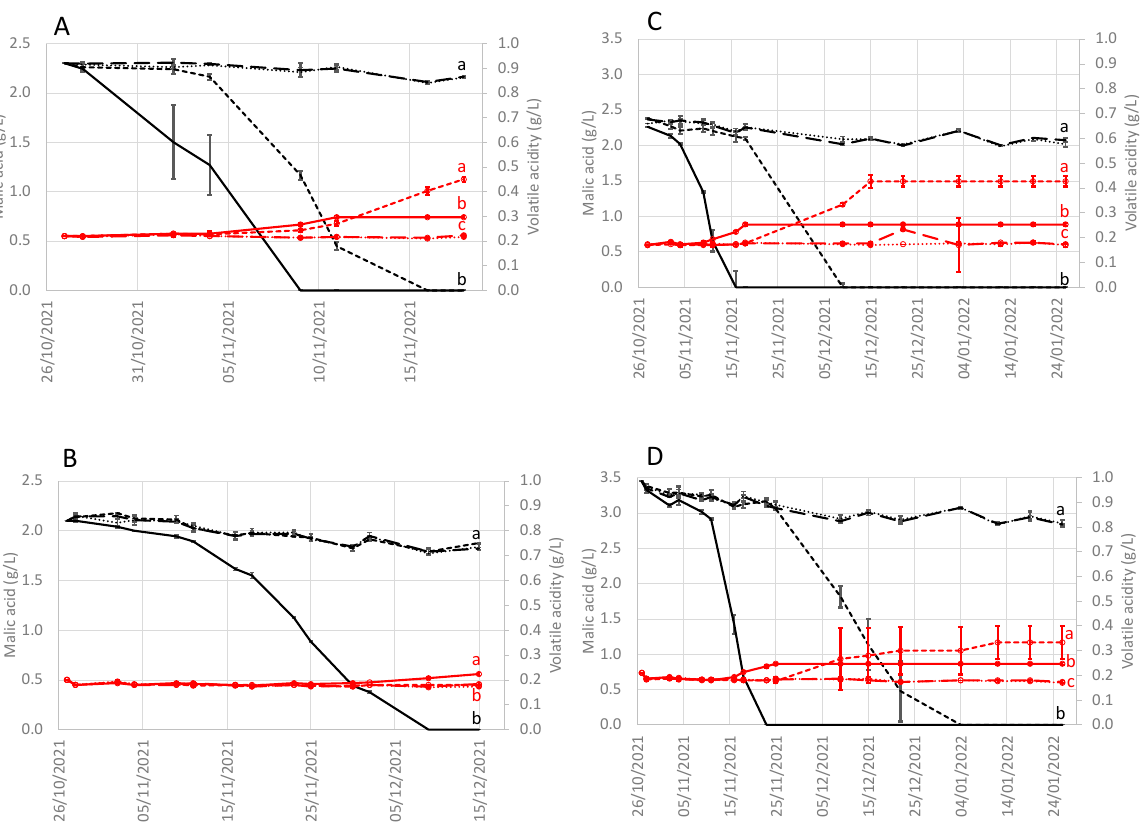
Figure 2. Evolution of malic acid (black lines) and volatile acidity (red lines with circles) (g/L) in spontaneous or inoculated (alpha, O. oeni ) MLFs with or without FH2 inhibition (600 mg/L) for trials performed in triplicate during 2021. Malic acid in control ( ), control with FA ( ), control with LAB ( ), and control with FA and LAB ( ). Volatile acidity in control ( ), control with FA ( ), control with LAB ( ), and control with FA and LAB ( ). ( A , B ) red wines from Tempranillo and Garnacha, respectively, ( C ) rose, ( D ) white wine. Values are the means and bars are standard deviations of three independent fermentations. Letters of last day represent sig- nificant differences.